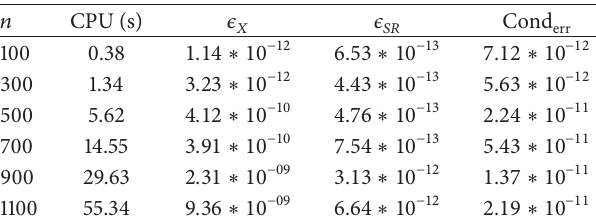
Table 1: Variant matrix sizes 𝑛 for the solutions to (2) with 𝑆𝑋 = 𝑋𝑅 constraint.